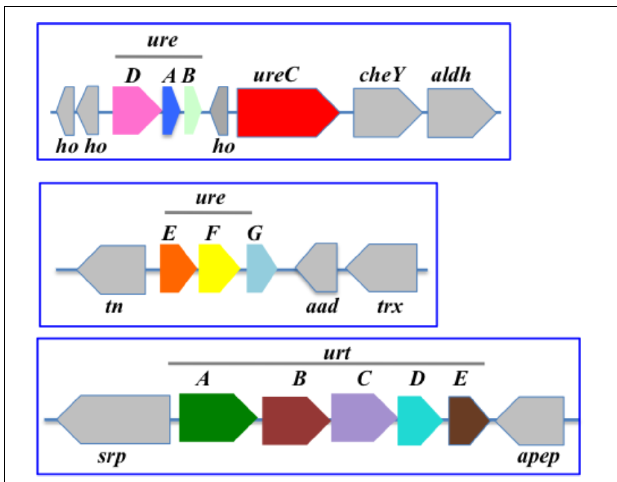
FIGURE 5 | Organization of the urea acquisition and catabolism genes in Nostoc PCC 7120. The genes are shown as colored boxes pointing in the direction of their transcription. Gray boxes correspond to genes not known to be involved in urea metabolism or transport. Each blue box corresponds to a genomic region. aad , acetoacetate decarboxylase; aldH , aldehyde dehydrogenase; apep, a minopeptidase; ho , hypothetical protein; cheY , chemotaxis protein CheY; tn, tranposase; srp , signal recognition particle; trx ,